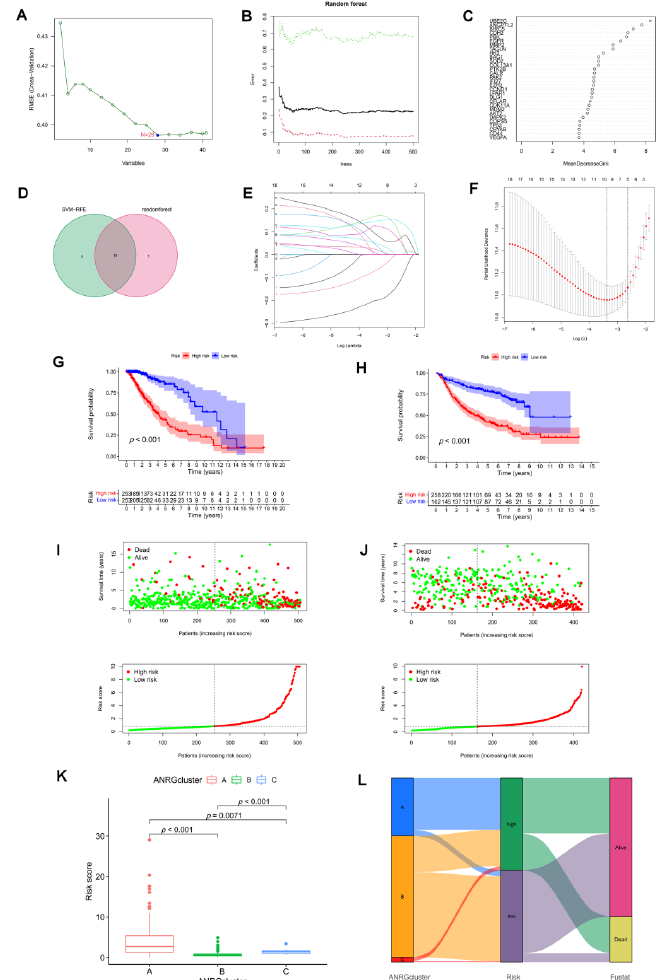
Figure 5. Identification of prognostic features associated with Anoikis. ( A ) A plot illustrating the process of selecting biomarkers using the support vector machine-recursive feature elimination (SVM-RFE) technique. The SVM-RFE technique was used to identify a subset of 28 characteristics from the DEGs. ( B ) The effect of the decision tree number on the error rate. The X-axis denotes the number of decision trees, while the y-axis shows the error rate. When approximately 240 decision trees are used, the error rate is generally steady. ( C ) The Gini coefficient method results in a random forest classifier. The x-axis displays the genetic variable, and the y-axis the significance index. ( D ) Venn diagram showing the feature genes shared by random forest, and SVM-RFE algorithms. ( E ) LASSO analysis with 10-fold cross-validation identified seven prognostic genes. Each curve corresponds to one gene. ( F ) Coefficient profile plots of seven prognostic ANRGs. Vertical dashed lines are plotted at the best lambda. ( G , H ) The KM curves showed a different prognosis in the subtype risk group. ( I , J ) Risk plots were used to illustrate the survival status of each sample in the TCGA and CGGA cohorts. ( K ) Risk score in 3 clusters established before. ( L ) Alluvial diagram of subtype and living